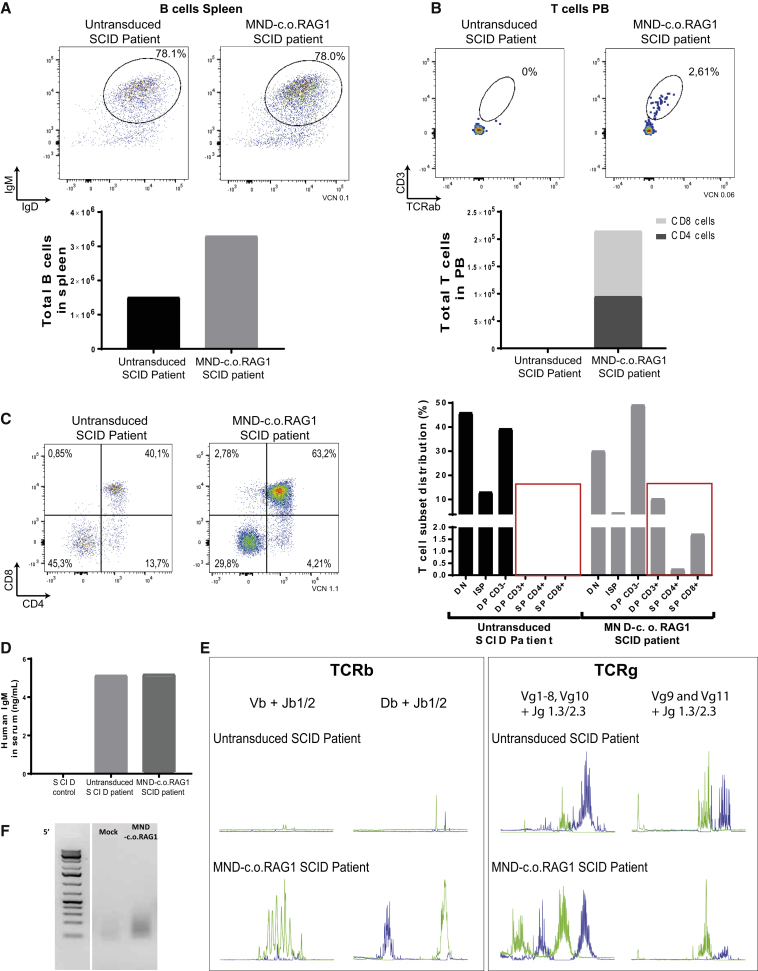
Restored T Cell Development in RAG1 SCID Patient Cells65,000 human CD34+ cells were transplanted intravenously into busulfan pre-conditioned NSG recipient mice (one NSG mouse with untreated cells and one NSG mouse with MND-c.o.RAG1 gene therapy cells with a VCN of 0.1). (A) FACS plots of human B cells (CD13/33−CD19+CD20+ cells; top panel) and total number of B cells (CD13/33−CD19+CD20+IgD/IgM cells; bottom panel) in the spleen at week 24 after transplantation. (B) FACS plots of human T cells (CD3+TCRαβ+; top panel) and total number of T cells, CD4 cells, and CD8 T cells in the PB at week 24 after transplantation (bottom panel). (C) Human T cell development in the thymus: FACS plots (CD4 versus CD8) and distribution of the different T cells subsets in the thymus (24 weeks after transplantation) are shown. (D) Quantification of total human IgM by ELISA of serum from a control NSG mouse transplanted with RAG1-SCID control untreated CD34+ cells (non-hypomorphic), our SCID patient CD34+ cells, and our SCID MND-c.o.RAG1 CD34+ cells. (E) Human TCR Vβ and Vγ repertoire analysis of isolated DNA from NSG thymus (SCID patient and SCID MND-c.o.RAG1) using a TCRB + TCRG T cell clonality assay (x axis indicates fragment sizes; y axis shows the fluorescence intensity of the runoff products). (F) LV insertion site analysis by nrLAM-PCR of isolated DNA from BM obtained from NSG SCID patient untransduced cells (mock) and NSG SCID MND-c.o.RAG1 mice. Gel shows results of the linear amplification from the 5′ LTR (L = 1 kb plus marker). Data are from an independent experiment with n = 1 per condition.